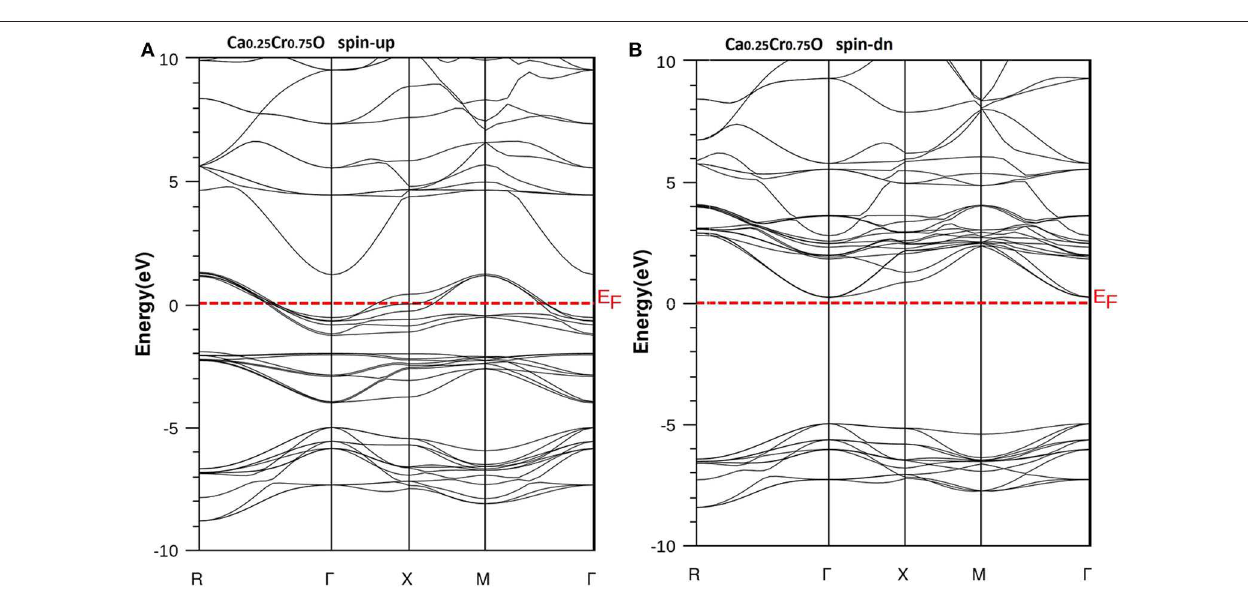
Chattopadhyaya, 2017a,b; Chattopadhyaya and Bhattacharjee, 2017; Berriah et al.,